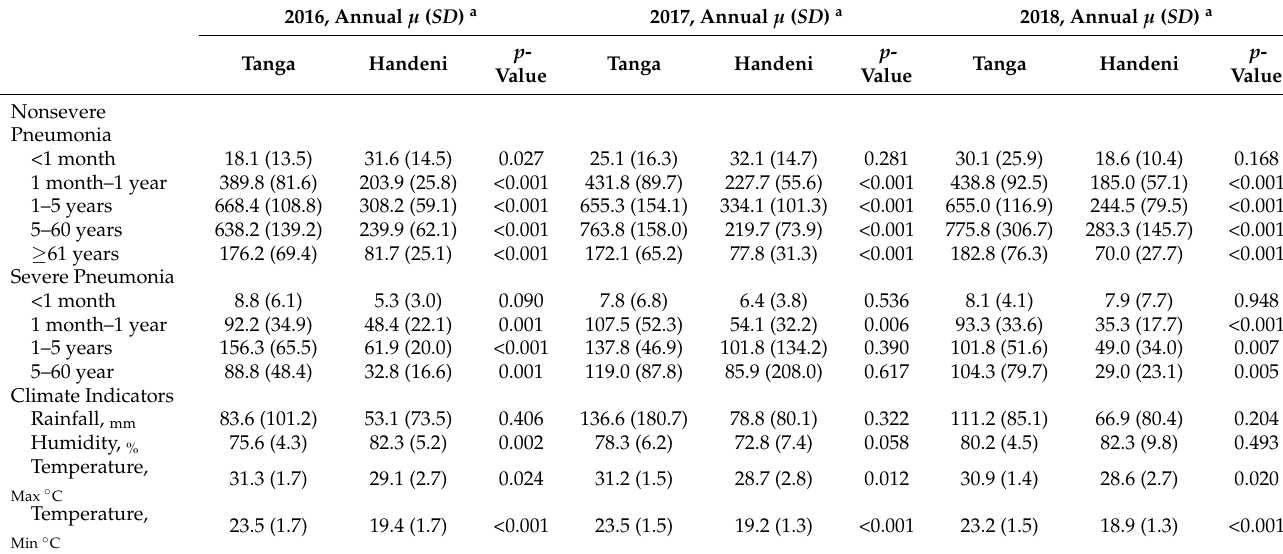
Table 1. The annual mean differences of pneumonia infections and climate variables between the Tanga and Handeni districts by